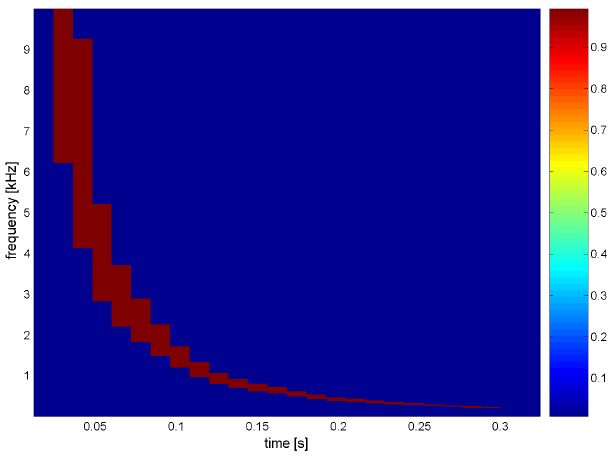
Fig. 1. Normalized reference whistler used for daytime cases. See the text for more